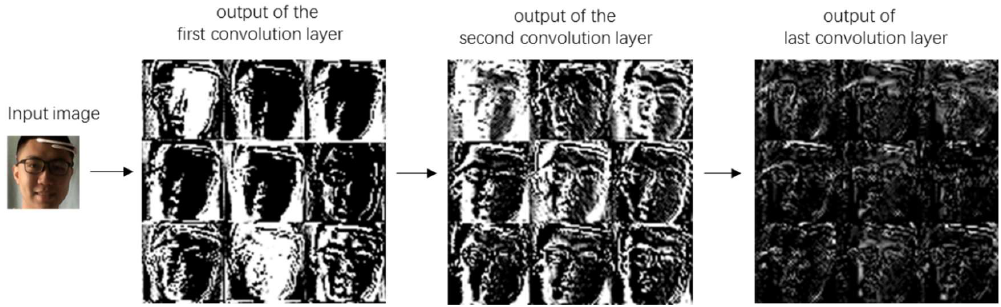
Figure 4. Visualization of spatial patterns that activate the nine selected outputs in the three convolutional layers of our pre-trained network .